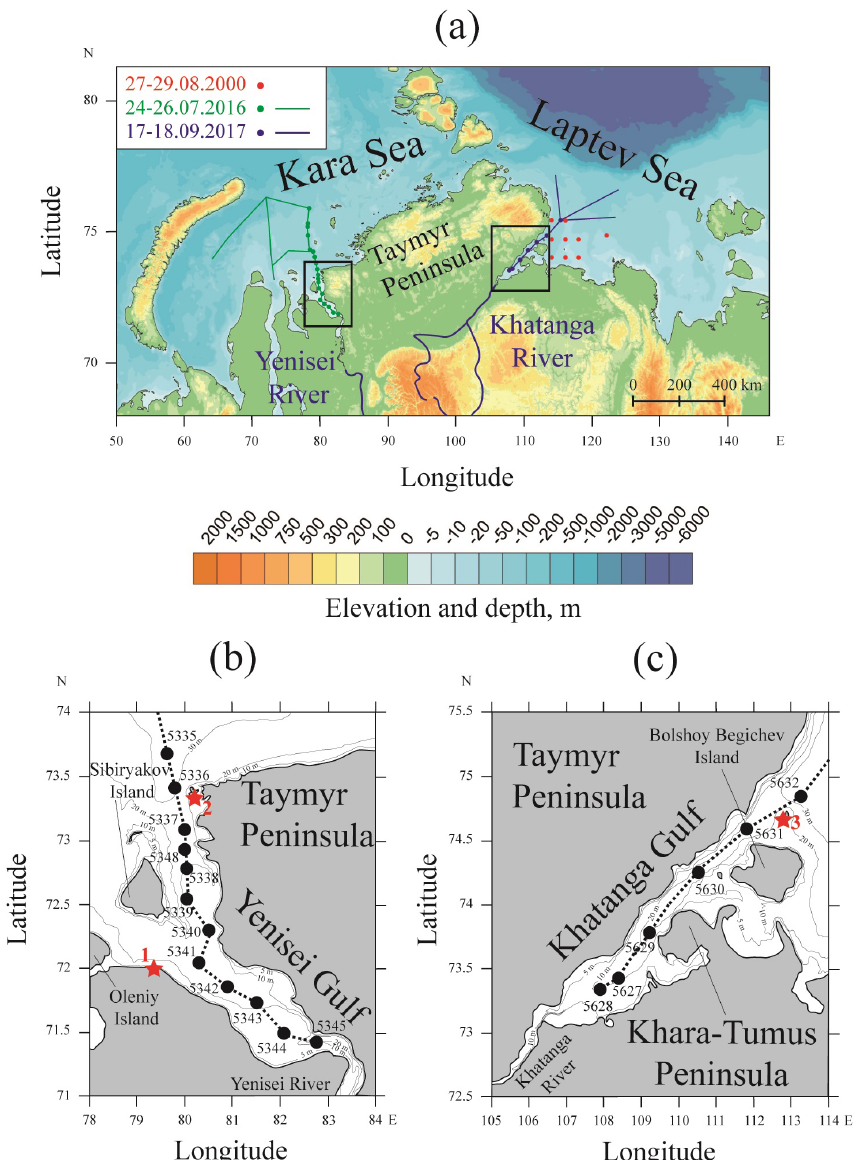
Figure 1. The bathymetry of the Kara and Laptev seas according to the International Bathymetric Chart of the Arctic Ocean (IBCAO) database; ship tracks (lines) and locations of hydrographic stations (circles) of three oceanographic field surveys conducted in August 2000 (red) and September 2017 (blue) in the Laptev Sea and in July 2016 (green) in the Kara Sea (a) . Ship tracks, and locations of hydrographic stations (black circles) and tidal gauge stations (red stars: 1 – Leskin, 2 – Dikson, 3 – Preobrazheniye) in the Yenisei (b) and Khatanga (c) gulfs. The graphic scale in panel (a) corresponds to the latitude of 73 ◦